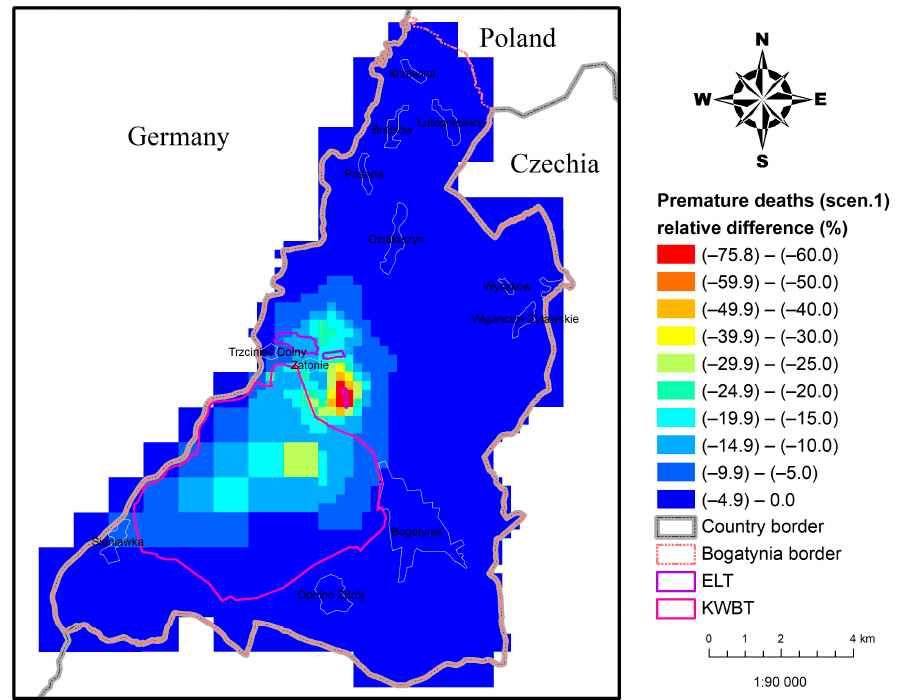
Figure 26. Spatial distribution of relative changes (reductions) in the number of premature deaths for scenario 1 relative to the baseline scenario. Energies 2020 , 13 , x FOR PEER REVIEW